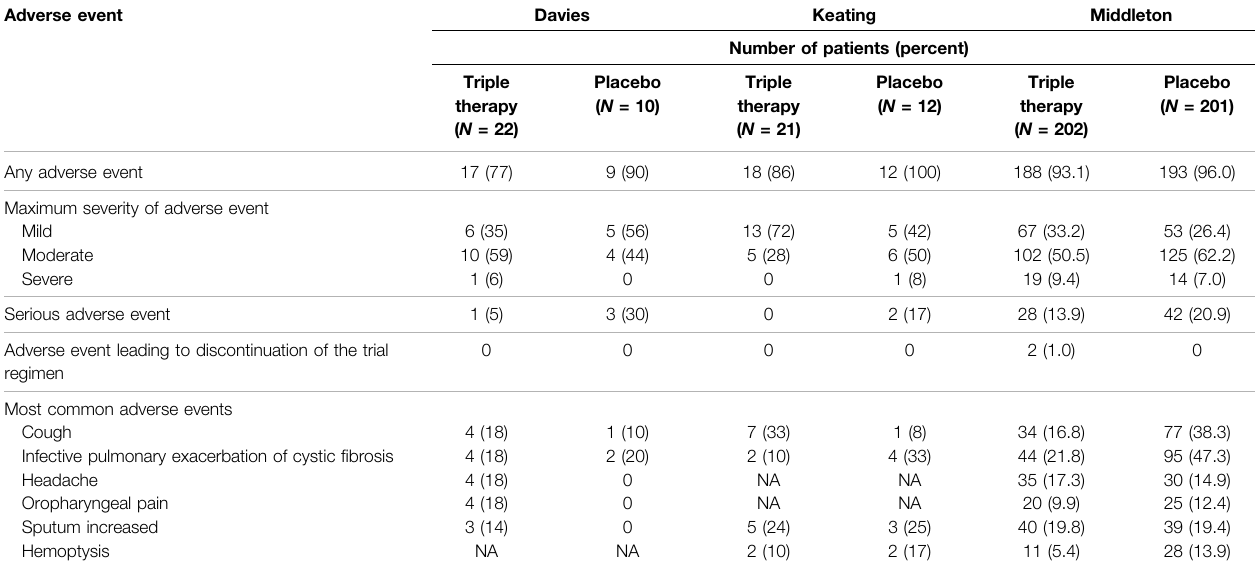
Number of patients